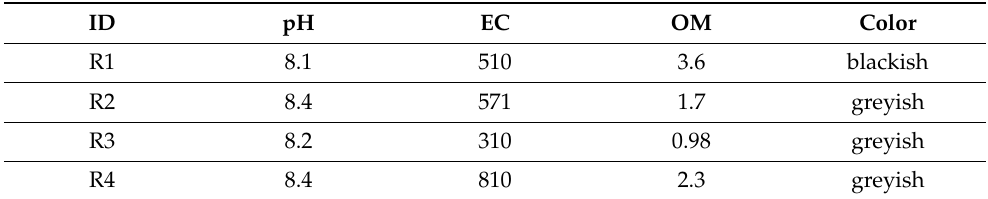
Table 1. Rhizosphere soils pH, electrical conductivity (EC; in µ S/cm), organic matter (OM; in %), and